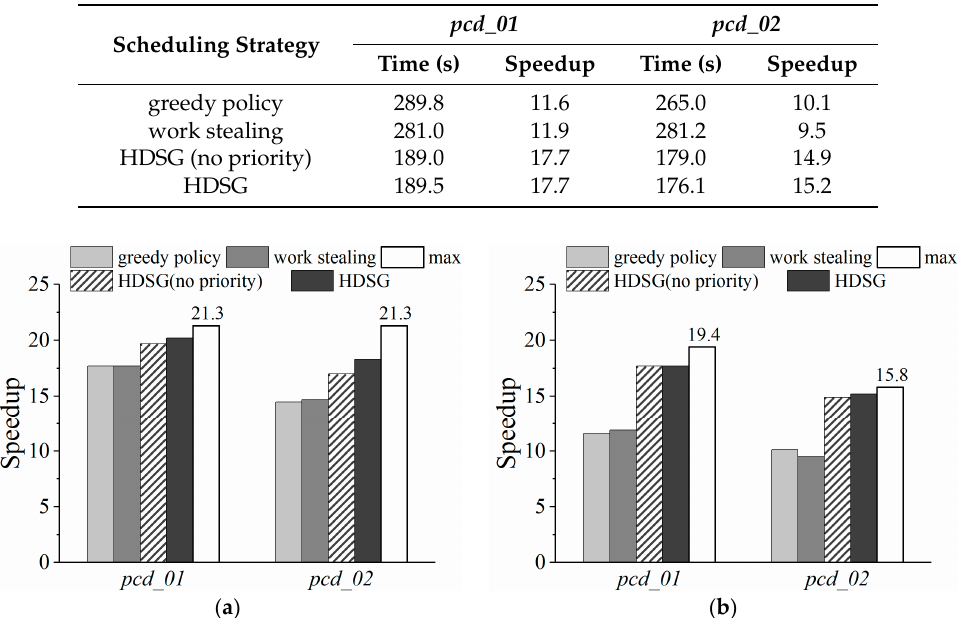
Table 8. Interpolation time (s) and speedups of the hybrid parallel algorithm with different scheduling strategies on hpc_02.